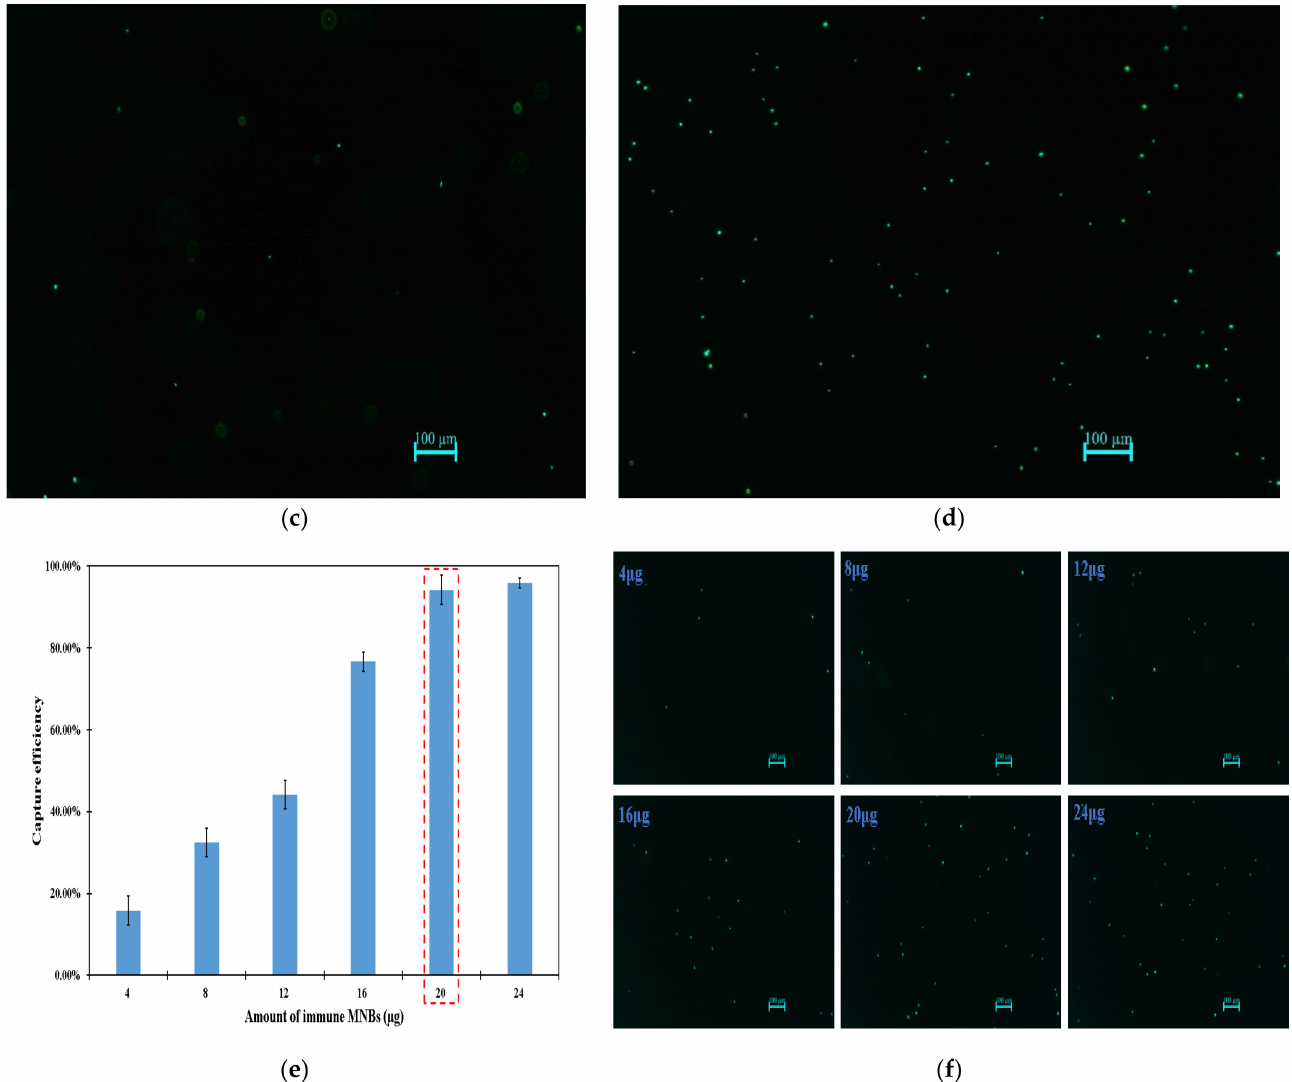
Figure 2. Characterization of low-gradient magnetic field and effect of MNBs on fluorescent signals. ( a ) Simulation of the magnetic field distribution on the surface of the cylindrical magnets. ( b ) Simulation of the magnetic field intensity on the surface of the cylindrical magnets. ( c ) The distribution of fluorescent spots without low-gradient magnetic field. ( d ) The distribution of fluorescent spots with low-gradient magnetic field. ( e ) Optimization of the amount of immune MNBs. ( f ) Fluorescence images for different dosages of MNBs. The scale bar is 100 µ